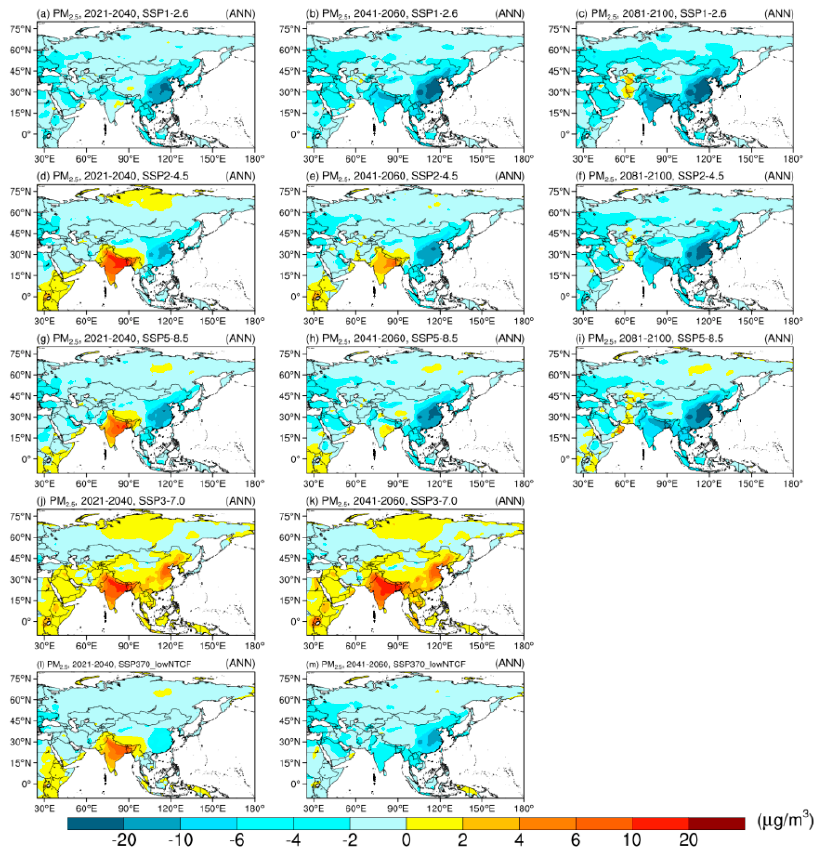
Figure 5. Spatial distribution of projected changes in surface PM 2.5 concentrations annually (units: µg/m 3 ) during 2021–2040, 2041–2060 and 2081–2100 under SSPs, relative to 1995–2014. The changes in dust vary in different sub-regions of Asia. Increases of dust are